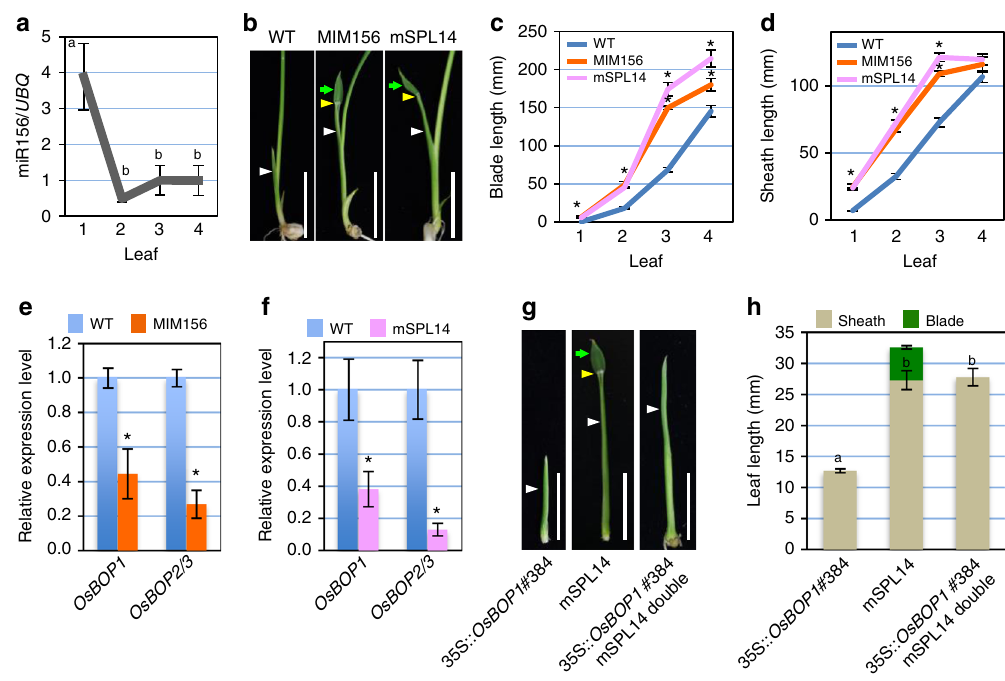
Fig. 7 miR156/SPL pathway regulates juvenile leaf traits in rice. a Relative expression level of miR156 in the fi rst to fourth leaves in the WT ( n = 3 biologically independent samples). The expression level of miR156 in the fi rst leaf is higher than that in the other leaves (Tukey-Kramer test, P < 0.05). b The fi rst leaf phenotype in the WT, in MIM156 and in mSPL14 lines. c , d The average length of leaf blade ( c ) and sheath ( d ) in WT, MIM156 and mSPL14 lines ( n = 5 biologically independent samples) Asterisks indicate a statistically signi fi cant difference compared to WT (Dunnett ’ s test, P < 0.05). e , f OsBOP1 and OsBOP2/3 expression levels in the fi rst leaf in WT and MIM156 lines ( e ) and in WT and mSPL14 lines ( f ). Each fi rst leaf was collected when it was emerging from the coleoptile ( n = 3 biologically independent samples). Asterisks indicate a statistically signi fi cant difference compared to WT (Student ’ s t -test, P < 0.05). g First leaf morphology in 35s:: OsBOP1 #384 (left), mSPL14 (middle) and an F1 plant carrying both 35s:: OsBOP1 and mSPL14 constructs (right). h The average length of leaf blade and sheath in the fi rst leaves in F2 siblings ( n = 6 biologically independent samples for 35s:: OsBOP1 ; n = 3 biologically independent samples for mSPL14; n = 12 biologically independent samples for 35s:: OsBOP1 and mSPL14 double line) (Tukey-Kramer test, P < 0.05). The relative expression values in the third leaf ( a ) and in the WT ( e , f ) are shown as 1.0. Green arrows, yellow arrowheads and white arrowheads indicate the leaf blade, blade/sheath boundary and leaf sheath, respectively, in the fi rst leaves ( b , g ). Error bars indicate standard error ( a , c – f , h ). Bars: 1 cm ( b , g ). Source data of Fig. 7a, c – f and h are provided as a Source Data fi